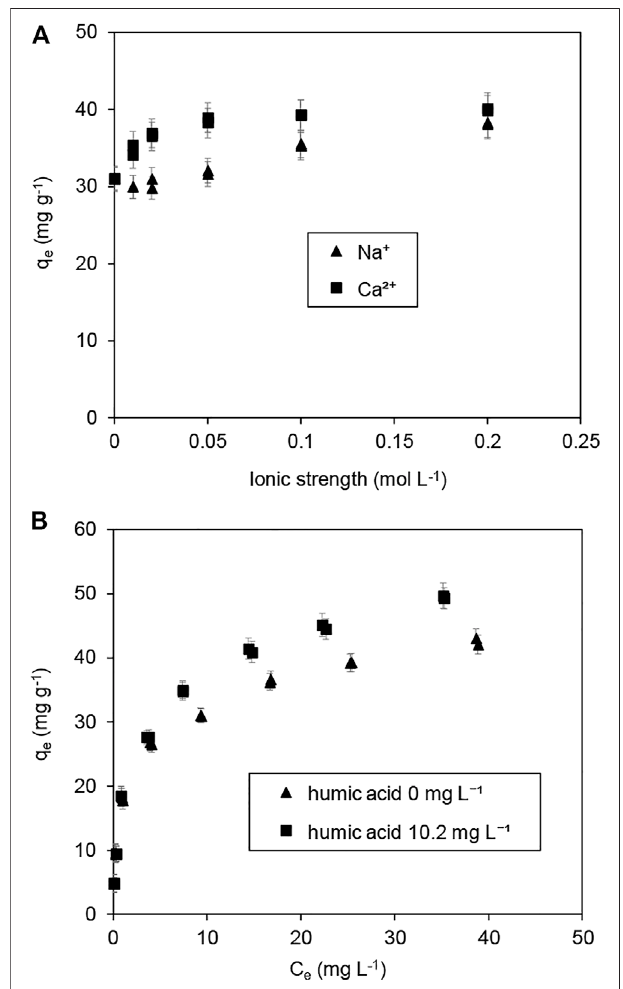
FIGURE 9 | (A) Effect of co-existing ions on Pb(II) adsorption over Fe 3 O 4 @SiO 2 -MnO 2 (1.54), and (B) adsorption isotherms of Pb(II) on Fe 3 O 4 @ SiO 2 -MnO 2 (1.54) in the absence and presence of dissolved humic acid. (Adsorbent dosage = 0.5 g L − 1 , Temperature = 25 ° C, pH = 4.0 ±